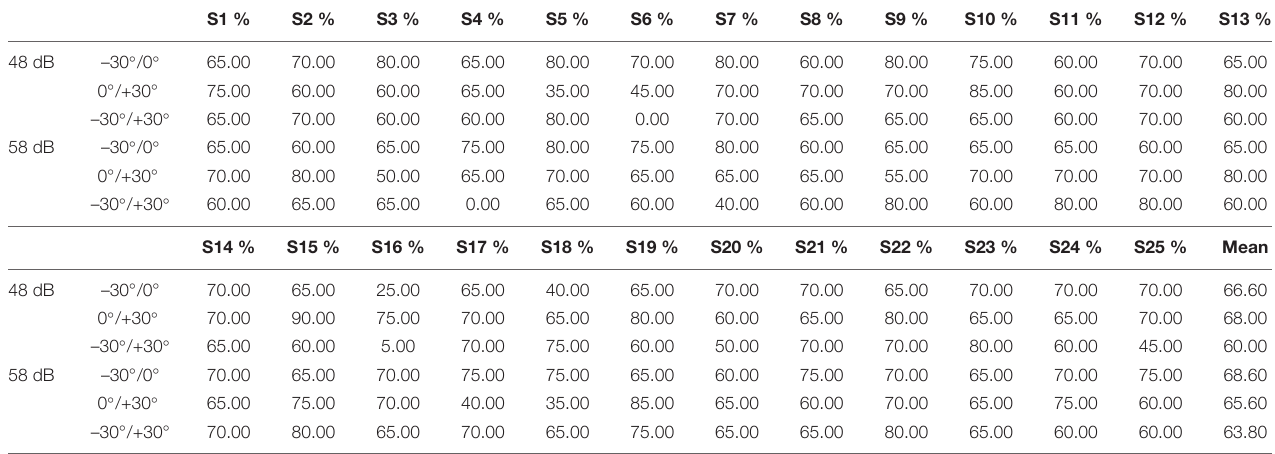
FIGURE 4 | Grand-average oxy-Hb response recorded between different sound levels in the same sound source for 10 ROIs. The blue line in solid and dashed lines on the panel represent oxy-Hb responses between high and low intensities at –90 ◦ . The shaded regions indicate the standard errors computed across all subjects for the relative condition. TABLE 4 | Classification accuracies of each participant using an optimal selected feature set for oxy-Hb response (–30 ◦ /0 ◦ /+30 ◦